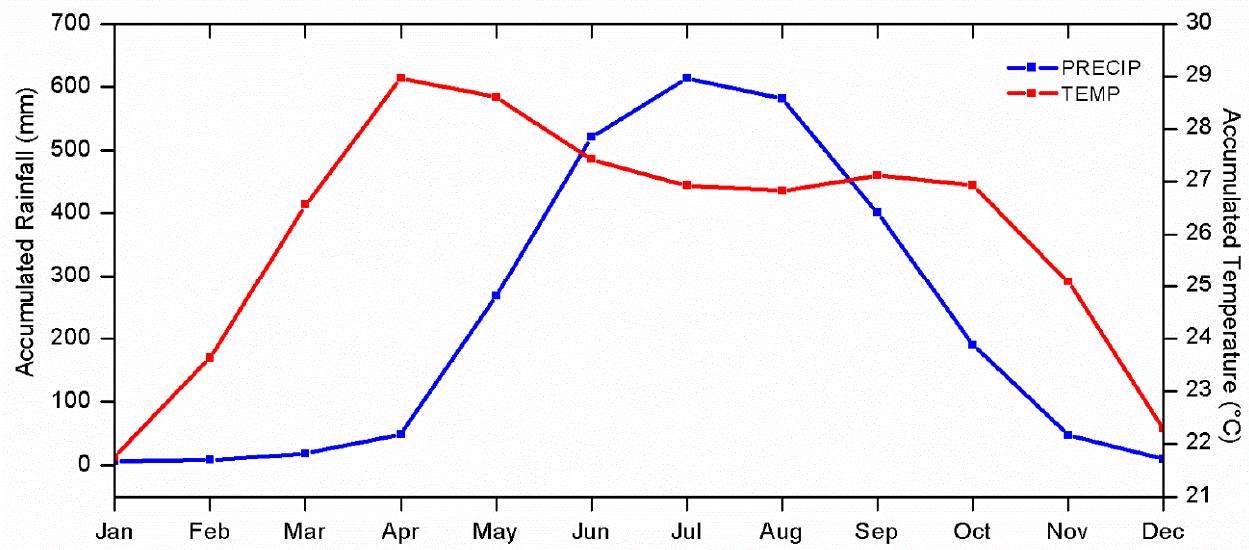
Figure 3. Annual cycle of rainfall (mm) (blue) and temperature (°C) (red) averaged from 1986 to 2015. In addition, we plotted the inter-annual variation in precipitation and temperature and precipitation exhibited an increasing trend.